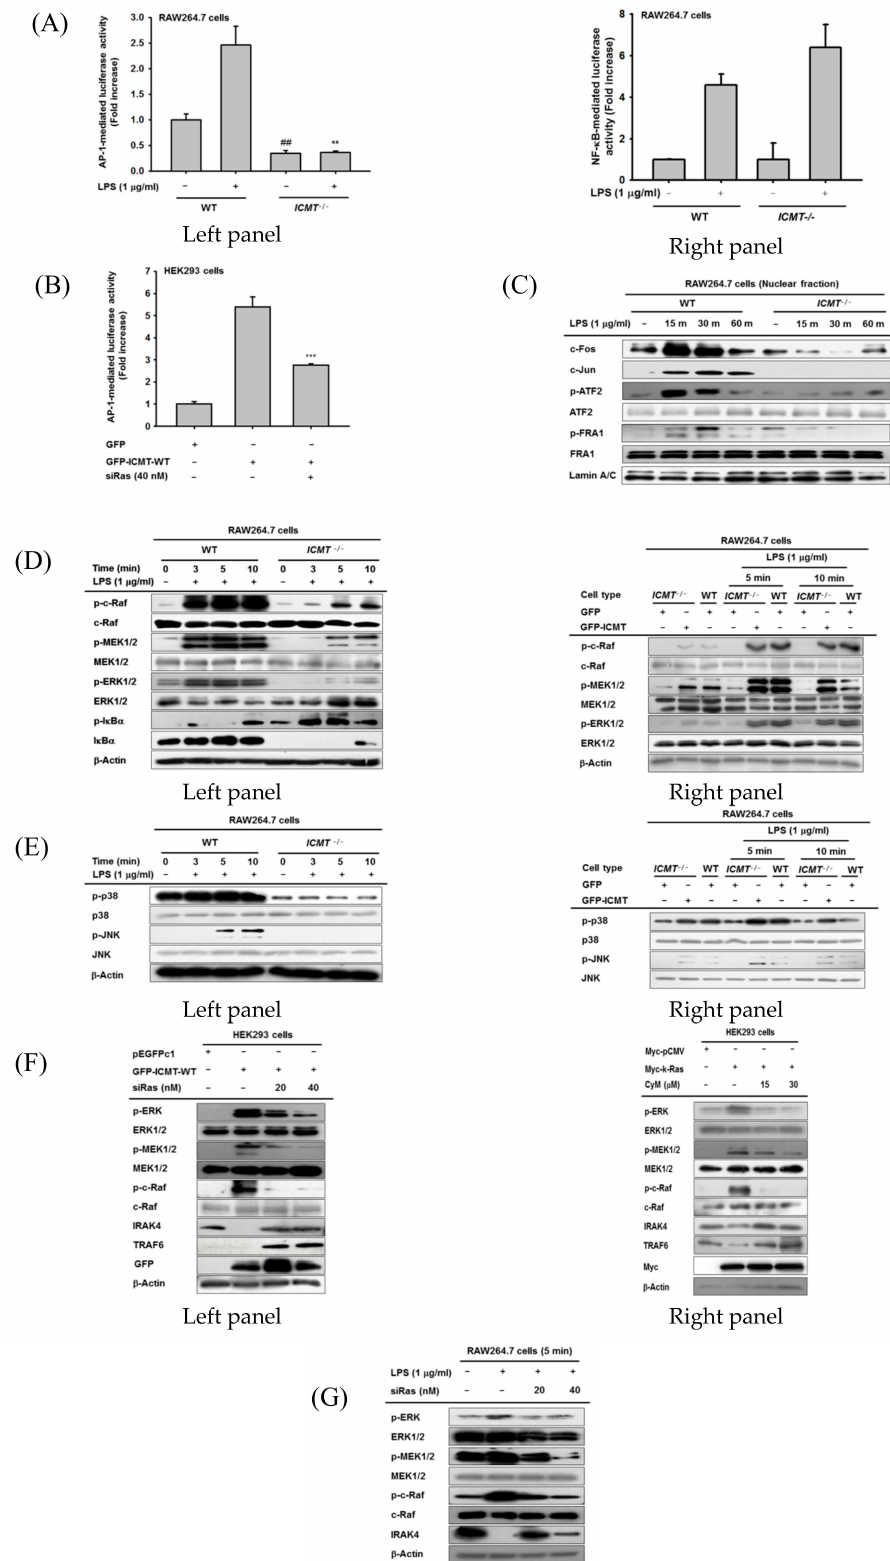
Figure 4. ICMT-mediated Ras activation reaches the AP-1 pathway. ( A ) AP-1 or NF- κ B-mediated luciferase activity was analyzed by reporter gene assay in RAW264.7-WT and RAW264.7- ICMT - / - cells treated with LPS (1 µ g /